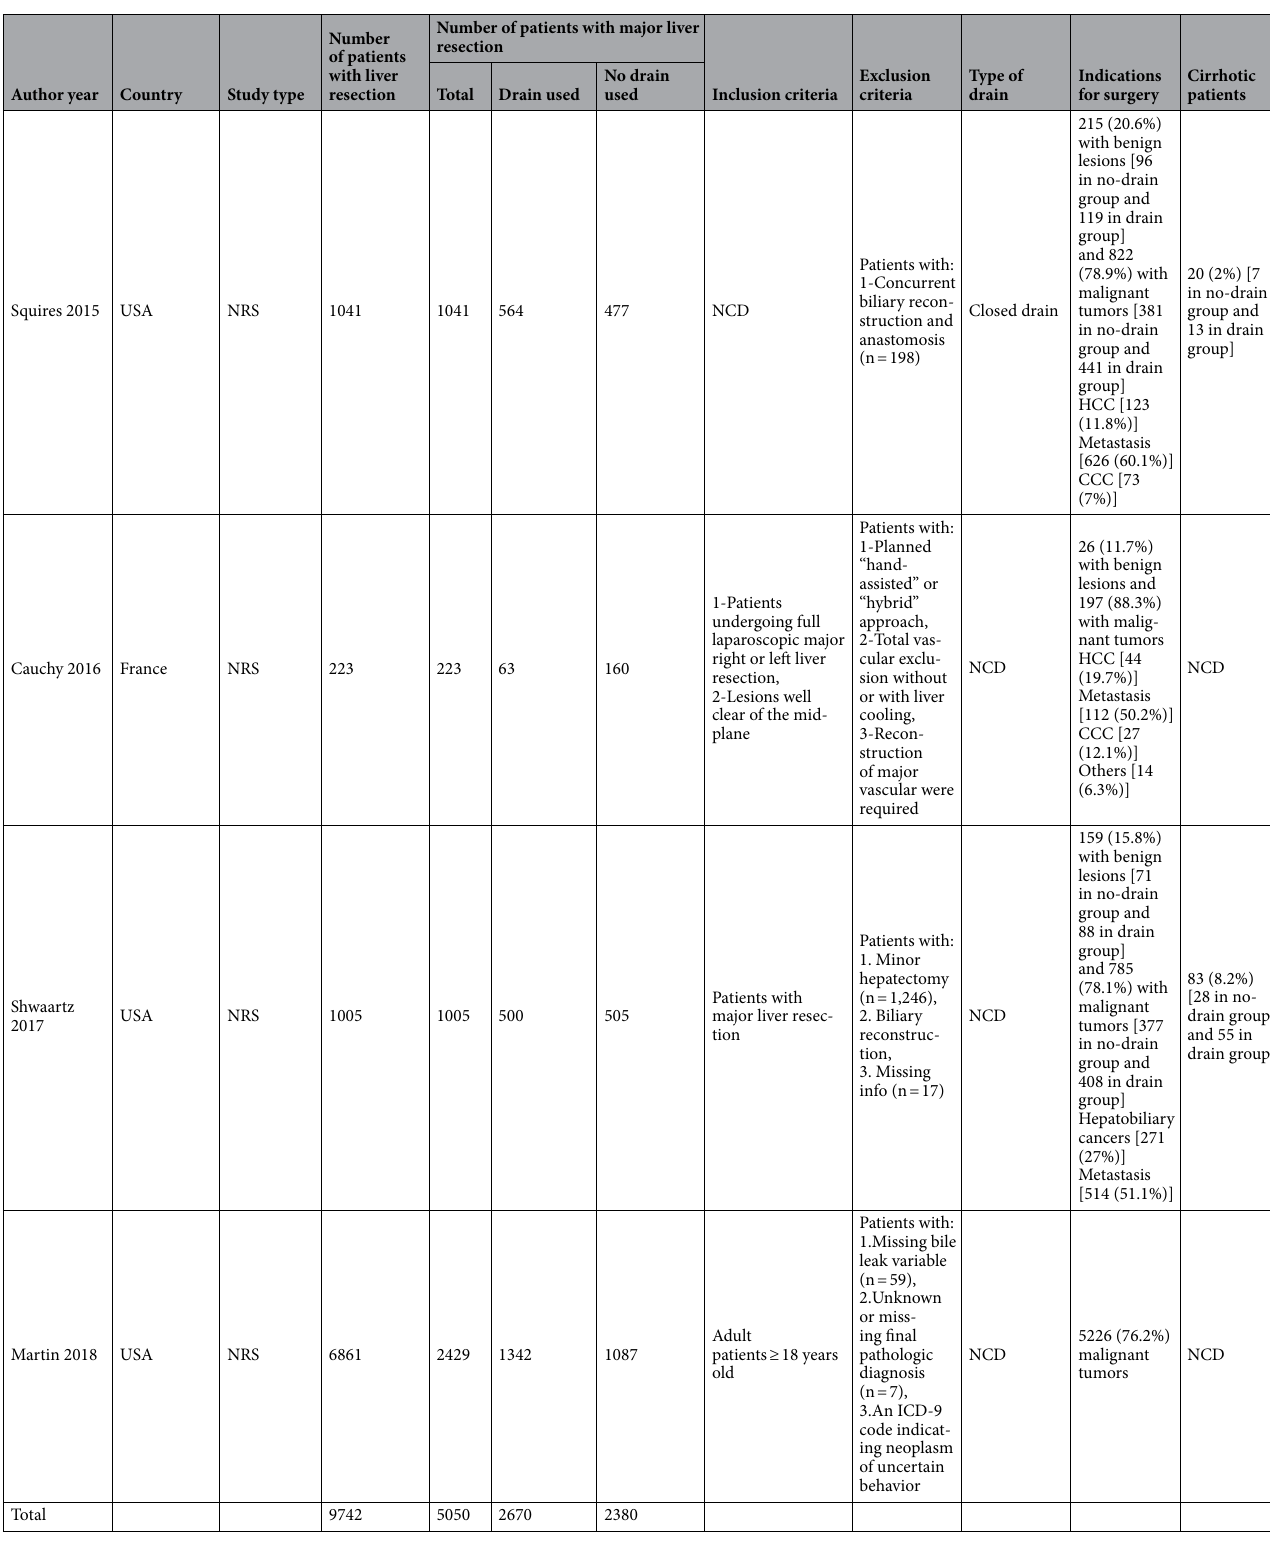
Table 1. Details and characteristics of studies. RCT Randomized controlled trial, NRS non-randomized studies, NCD not clearly defined, HCC hepatocellular carcinoma, CCC